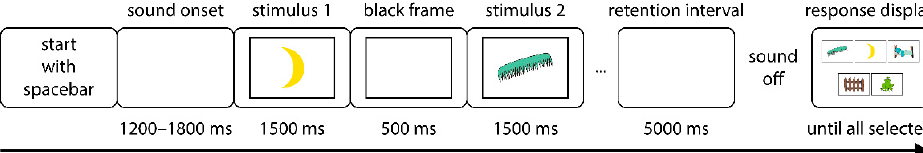
Figure 4. The serial recall task’s experimental procedure. Five pictures per trial were shown to the children, whereas eight pictures per trial were presented to the adults. All pictures seen in the re- spective trial were randomly arranged in an array of 5 (children) and 8 (adults) frames in the re- sponse